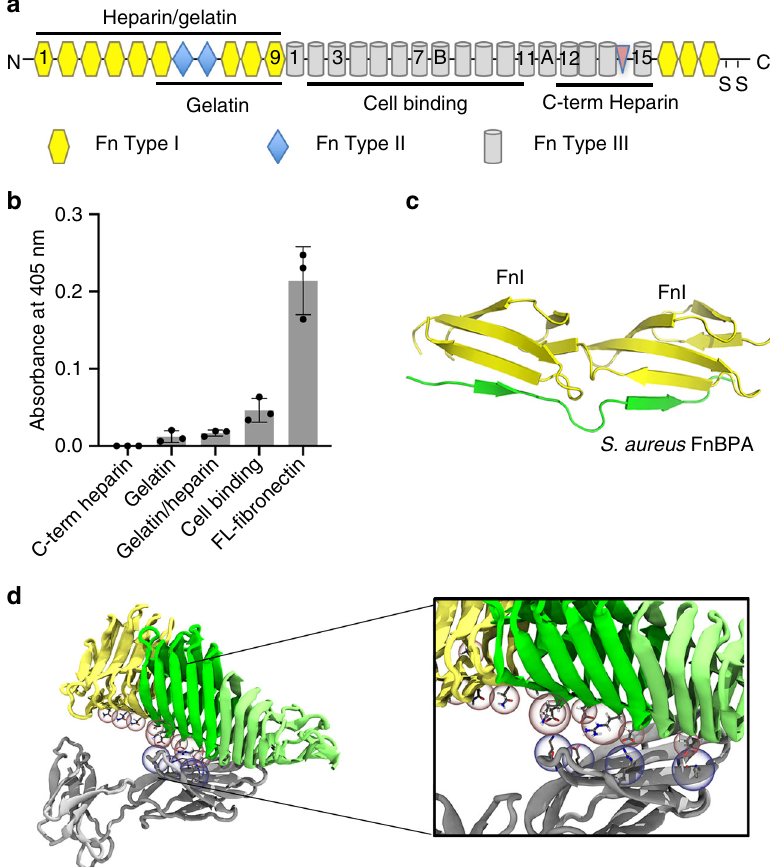
Fig. 4 UpaB binds fi bronectin type III. a Fibronectin domain organisation composed of 12 type I modules (FnI), 2 type II modules (FnII) and 15 – 17 type III modules (FnIII). Commercially available fragments used in this work include the heparin/gelatin FnI 1 – 9 , FnII 1 – 2 , the gelatin FnI 6 – 9 , FnII 1 – 2 , the cell binding FnIII 2 – 11 and the C-terminal heparin FnIII 12 – 15 fragments. b Binding of fi bronectin fragments, as well as full-length (FL) fi bronectin, to UpaB measured by enzyme-linked immunosorbent assay using an UpaB-speci fi c polyclonal antibody. Data are shown as the mean ± standard deviation of three replicates. c Tandem β -zipper interaction between Fn binding repeat peptides from S. aureus Fn-binding protein A (FnBPA) and Fn type I modules 2 and 3. The established mode of interaction between bacterial proteins and fi bronectin involves the donation of up to 11 structurally disordered bacterial fi bronectin repeats to form additional β -strands with consecutive FnI modules. d Model of the UpaB-FnIII interaction derived from NAMD simulations using the structures of UpaB and the FnIII 1 – 2 fragment (PDB: 2HA1), showing predominately hydrogen bonding between charged residues of UpaB (in particular, D246, D310, D336 and D375) and FnIII 1 (residues K32, R36, K40 and E70). The equivalent mutant simulation did not show any appreciable hydrogen